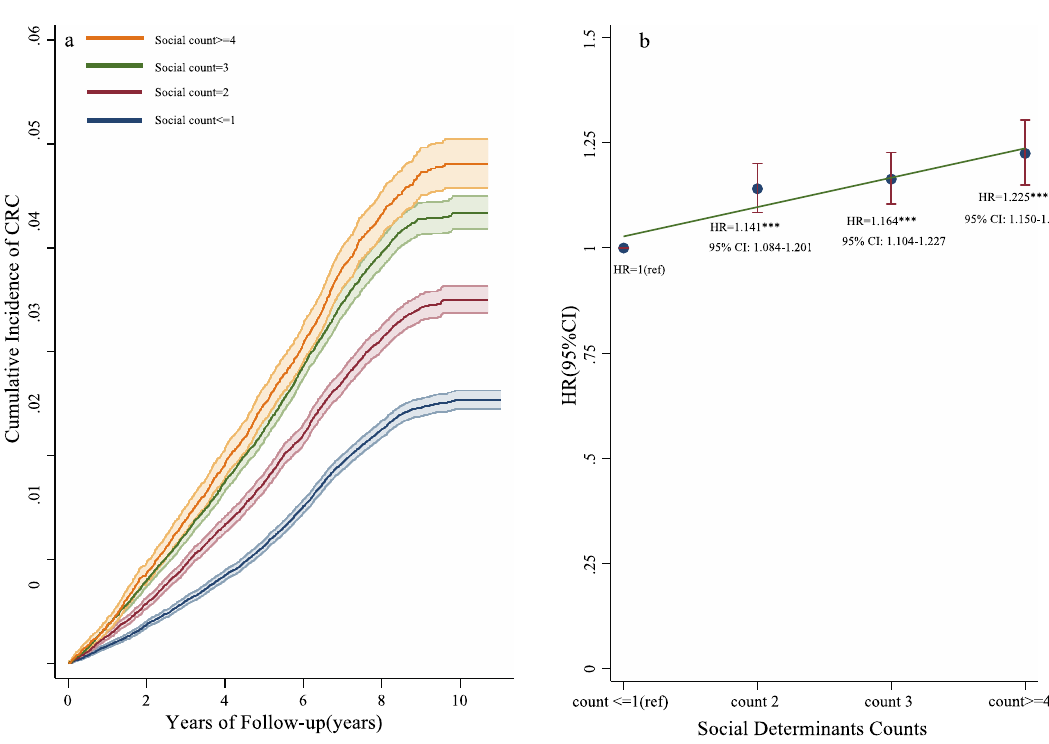
Figure 5. Effects of disadvantageous social determinants counts on the risk of incident CRC in the UKB